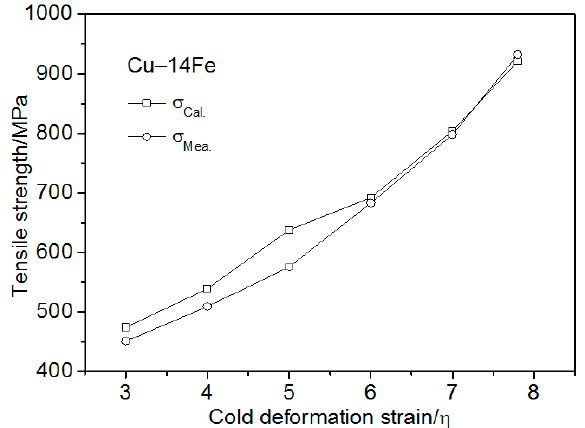
Figure 10. Cu–14Fe strength as-measured and calculated using the improved Hall–Petch relation vs. the cold deformation strain.